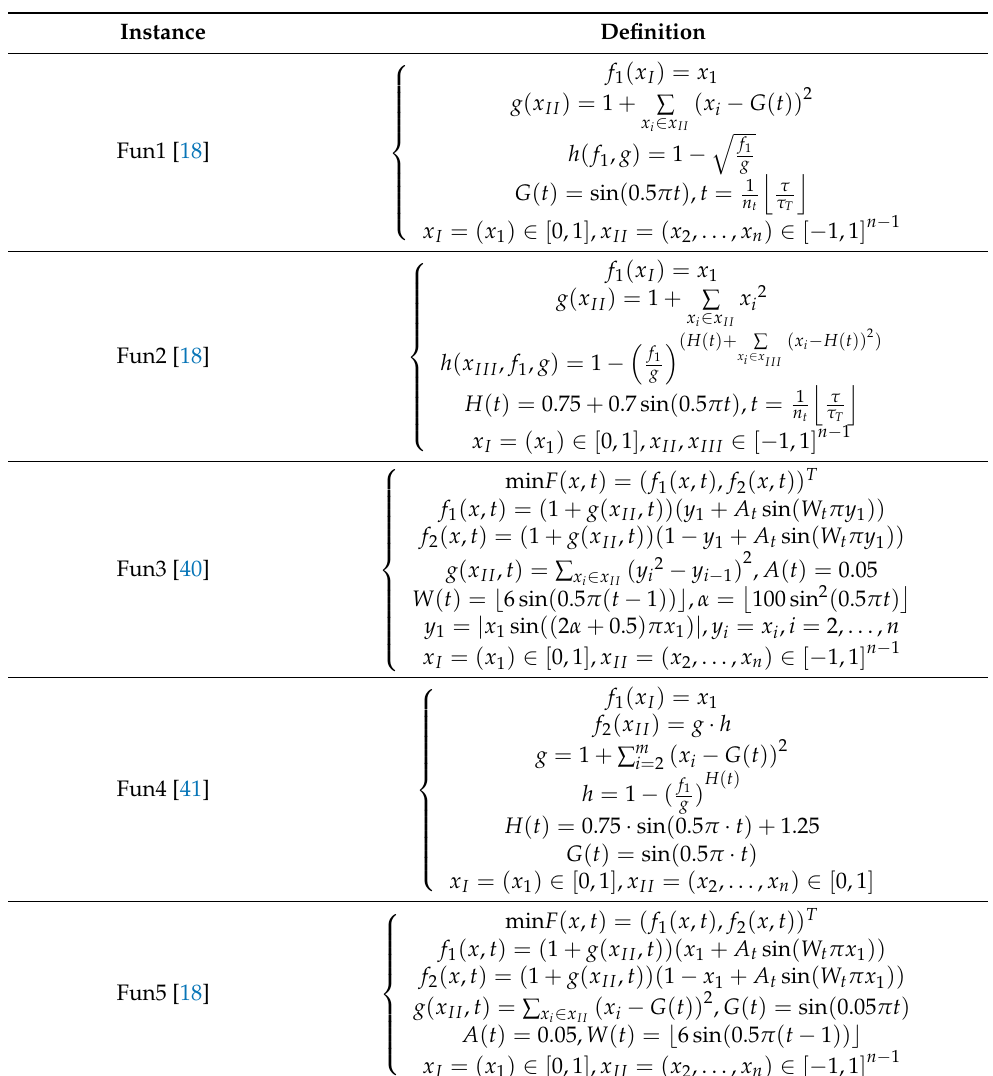
Table 1. The instances and definitions of six